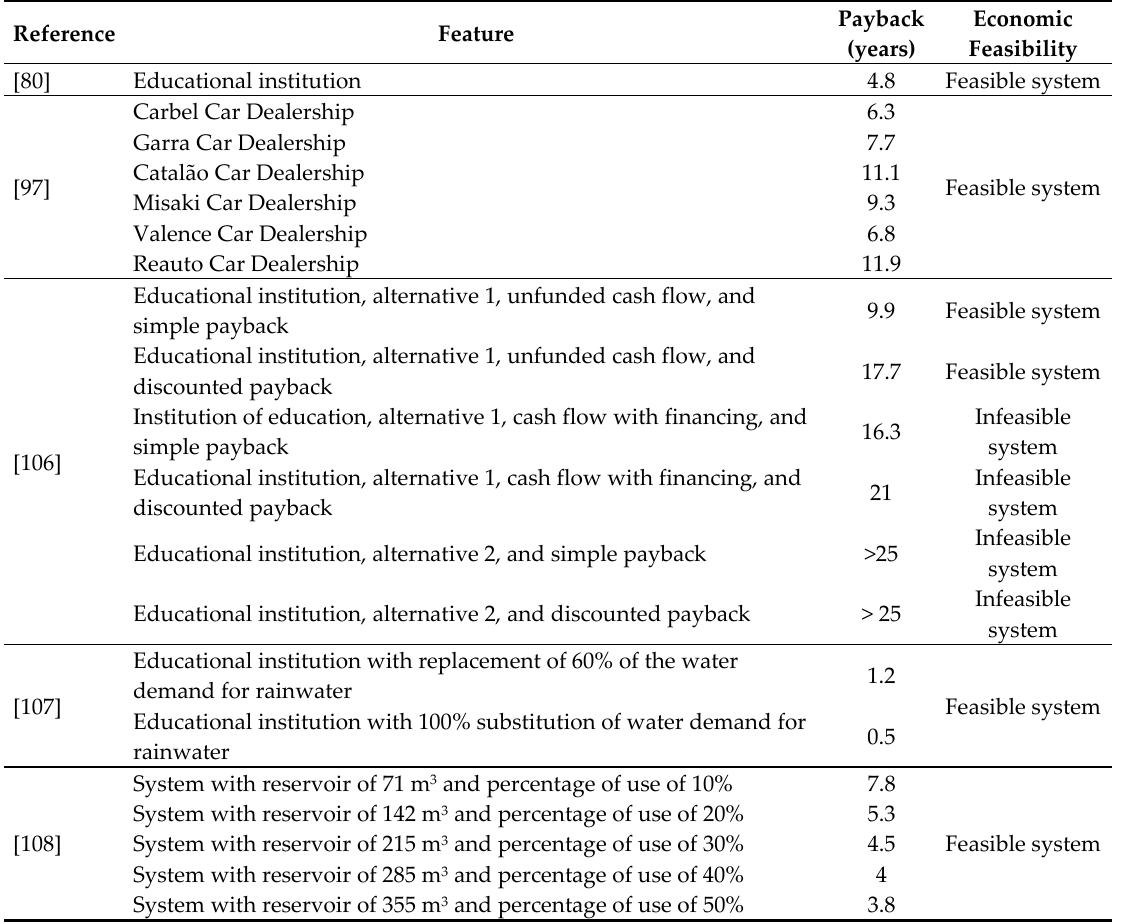
Table 3. Paybacks for the implantation of rainwater harvesting systems in commercial and public